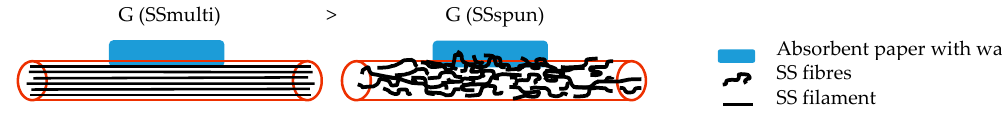
Figure 11. Short circuit: physical structure influence for spun and multifilament yarns.